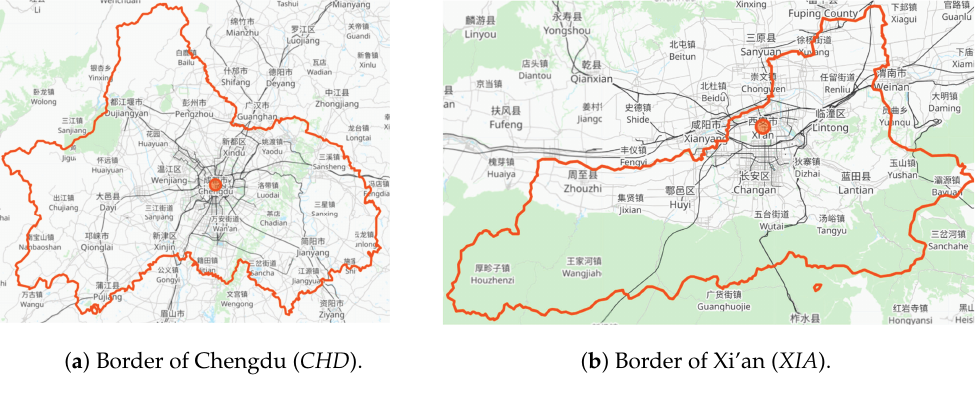
Figure 5. City borders.